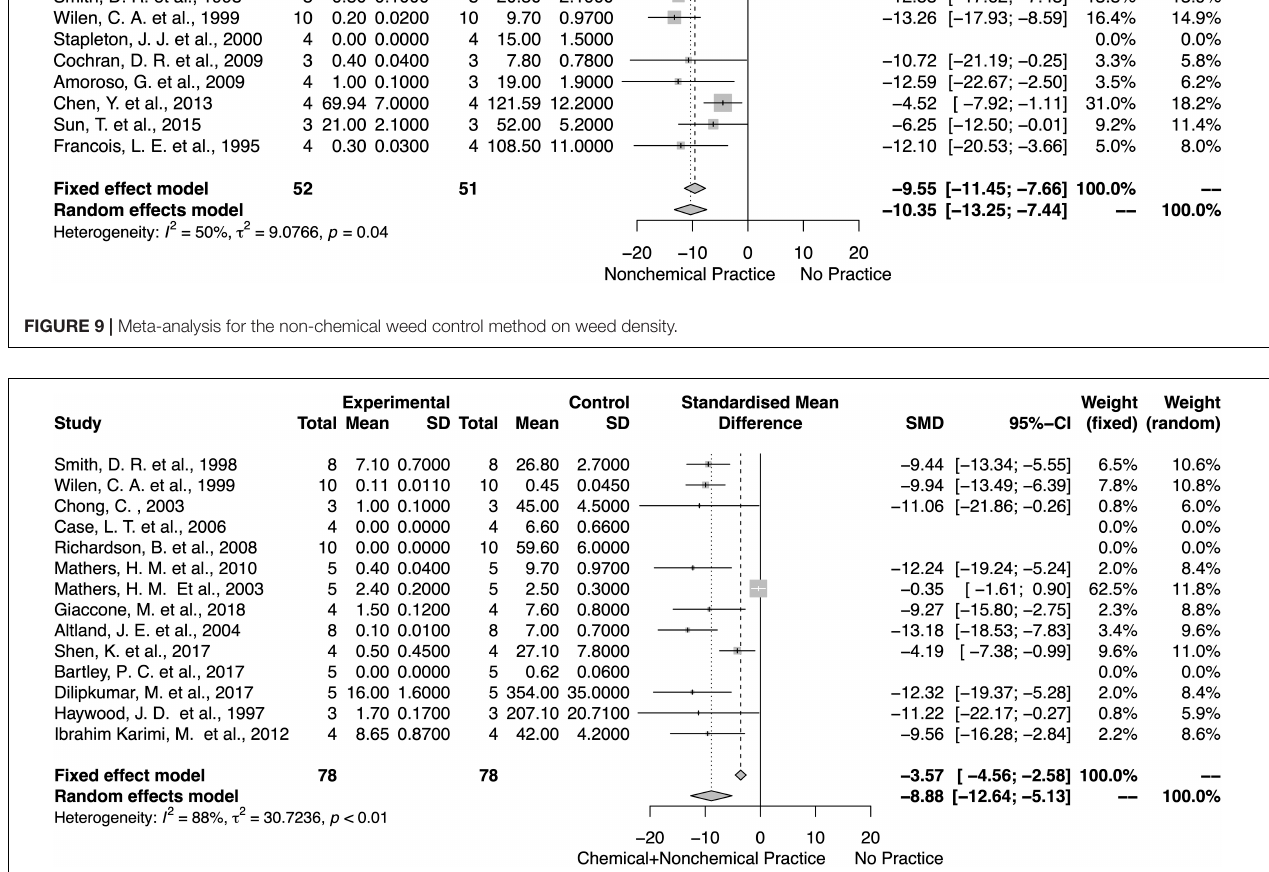
FIGURE 10 | Meta-analysis for the chemical and non-chemical combined weed control method on weed